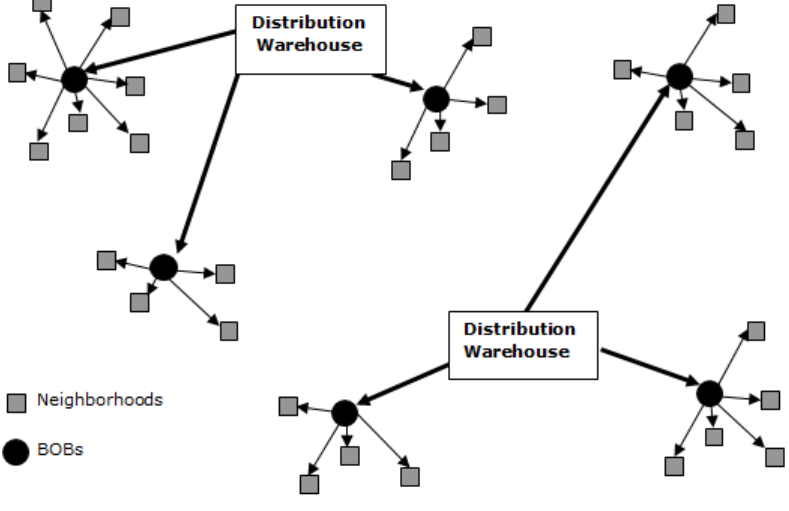
Figure 1. Distribution strategy for emergency relief goods (Horner & Downs,